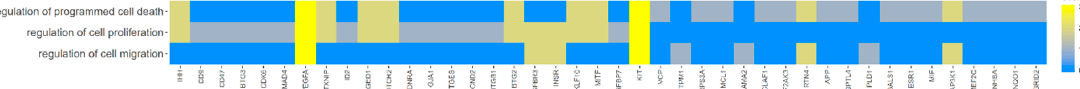
Figure 3. The representation of the mutual relationship between differentially expressed genes that belongs to the “cell proliferation”, “regulation of programmed cell death”, and “regulation of cell migration”. The ribbons indicate which gene belongs to which categories. The middle circle represents logarithm from fold change (LogFC) between D7/D1, D15/D1 and D30/D1 respectively. The genes were sorted by LogFC from the most to the least changed gene.